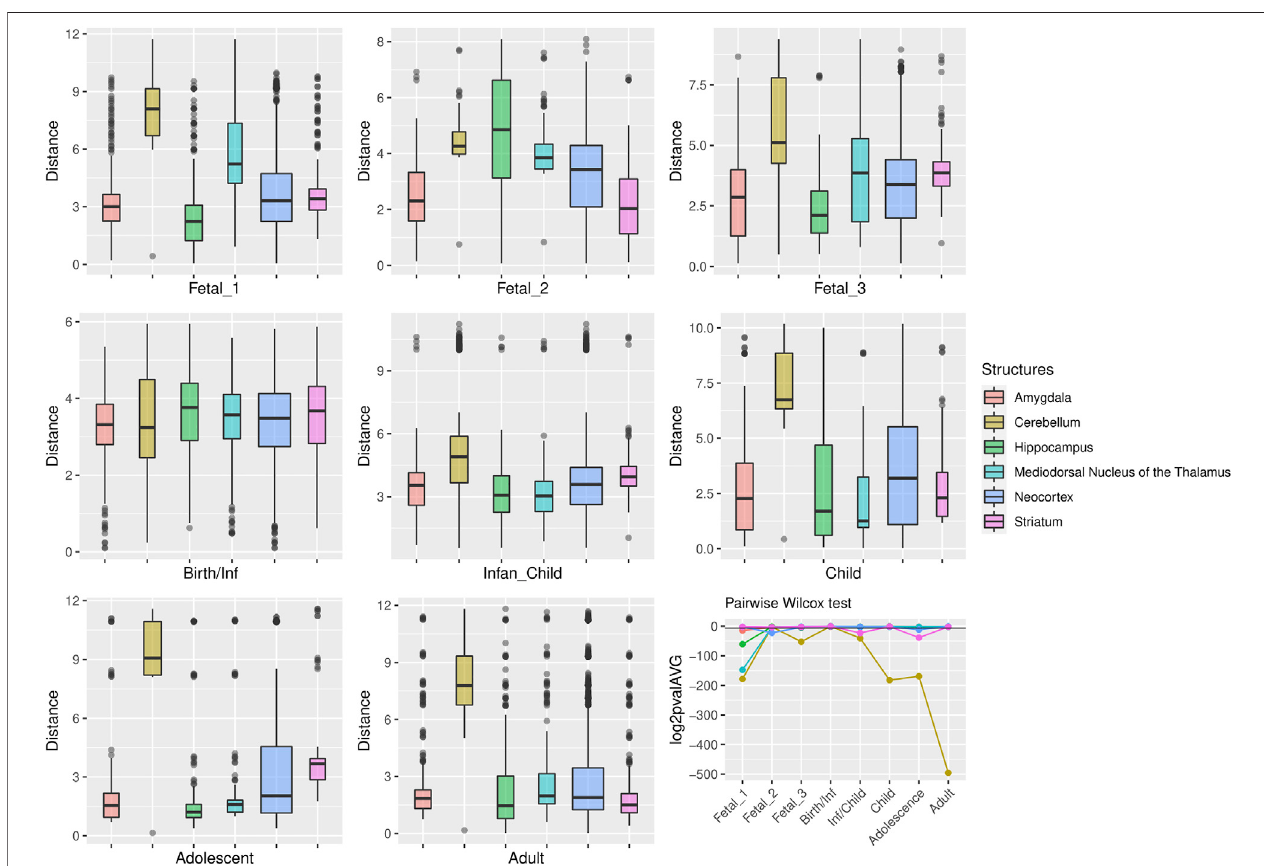
FIGURE 5 | Genes under positive selection within large deserts. The two fi rst principal components were selected to calculate the pairwise comparisons between structures at each stage (Wilcoxon test with Bonferroni correction). Signi fi cant results were obtained for the cerebellummore prominently at childhood p = 1.64 ×10 − 55 , adolescence p = 1.45 × 10 − 51 , and adulthood p = 5.83 × 10 − 150 . Prenatally the cerebellum and the thalamus show the most signi fi cant differences in comparison to the rest of structures, at fetal stage 1 ( p = 2.1 × 10 54 and p = 4.47 × 10 − 45 , respectively). Other signi fi cant results are found at speci fi c stages for the striatum (infancy and adolescence), neocortex (fetal stage 2), or the amygdala (fetal stages 1 and 3). The horizontal black line in the line plot denotes p = 0.01.